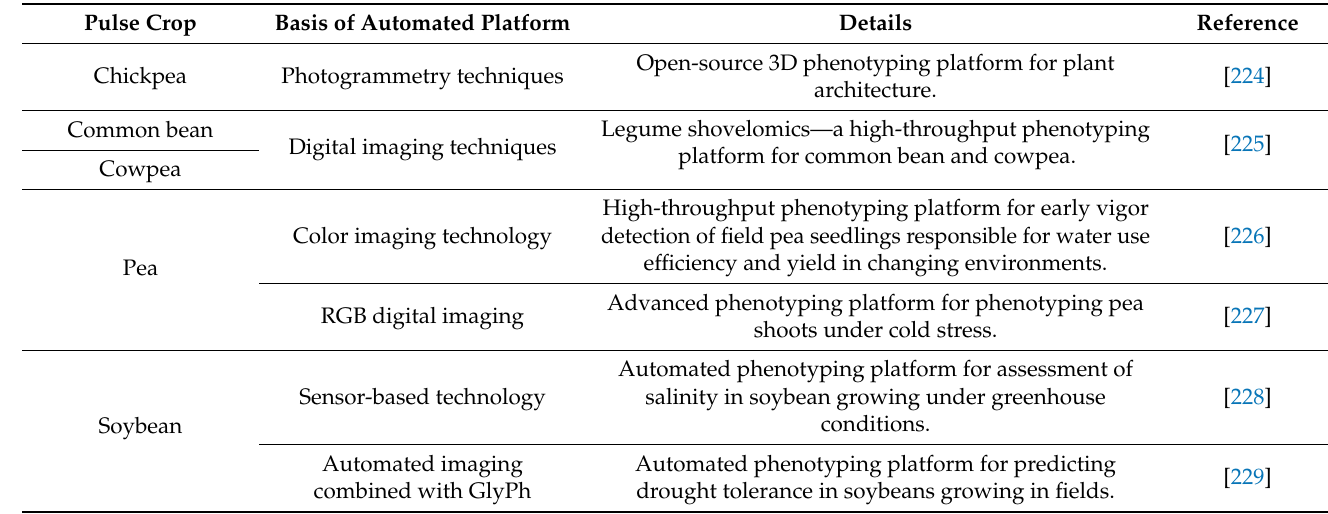
Table 9. Automated phenotyping platforms for screening pulse crops in changing